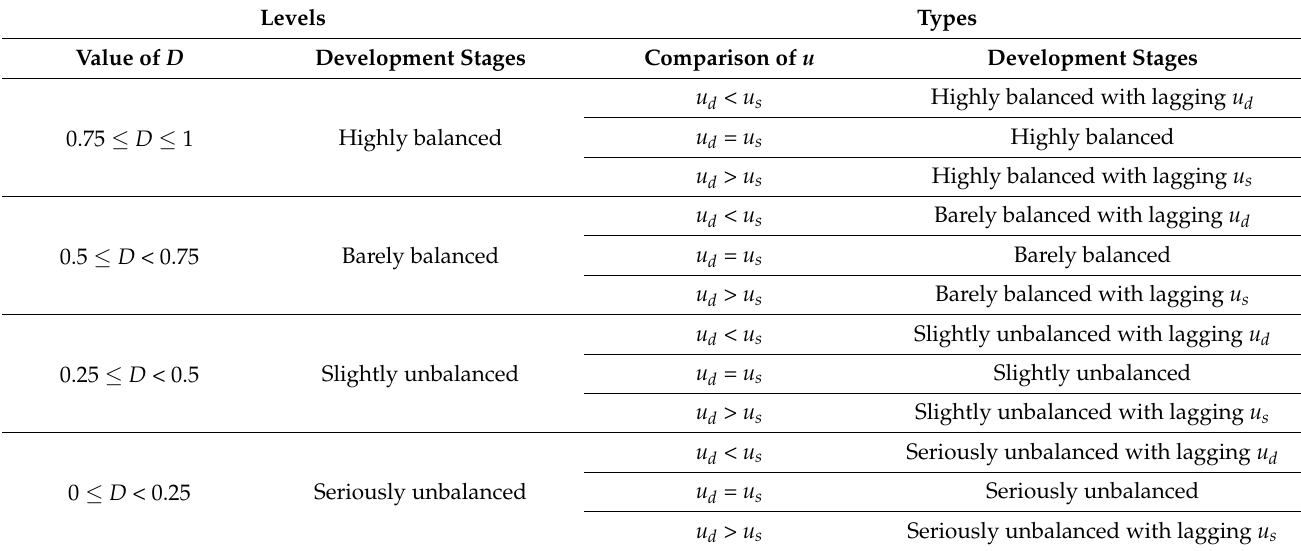
Table 2. Coupling coordination degree levels and